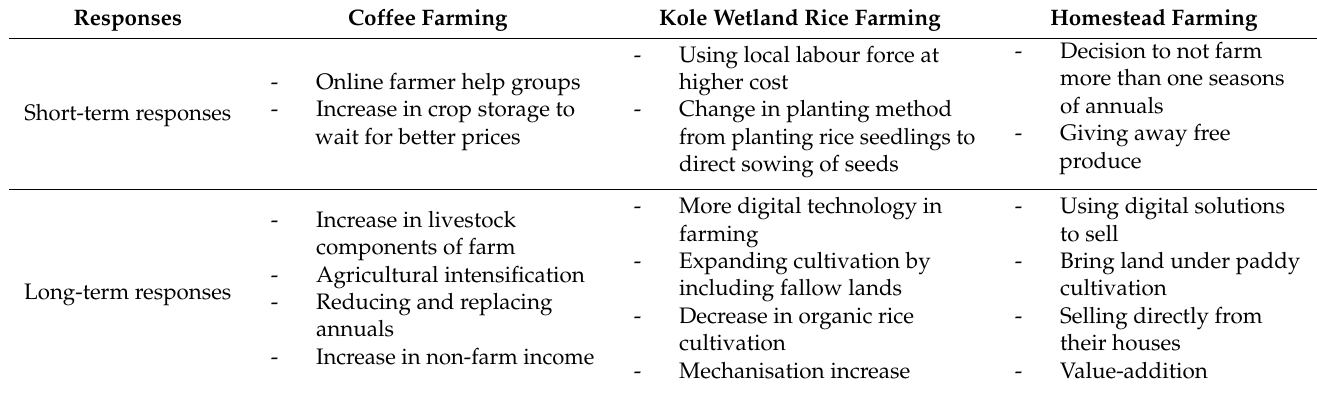
Table 3. Types of responses in different farming systems to the impacts of the